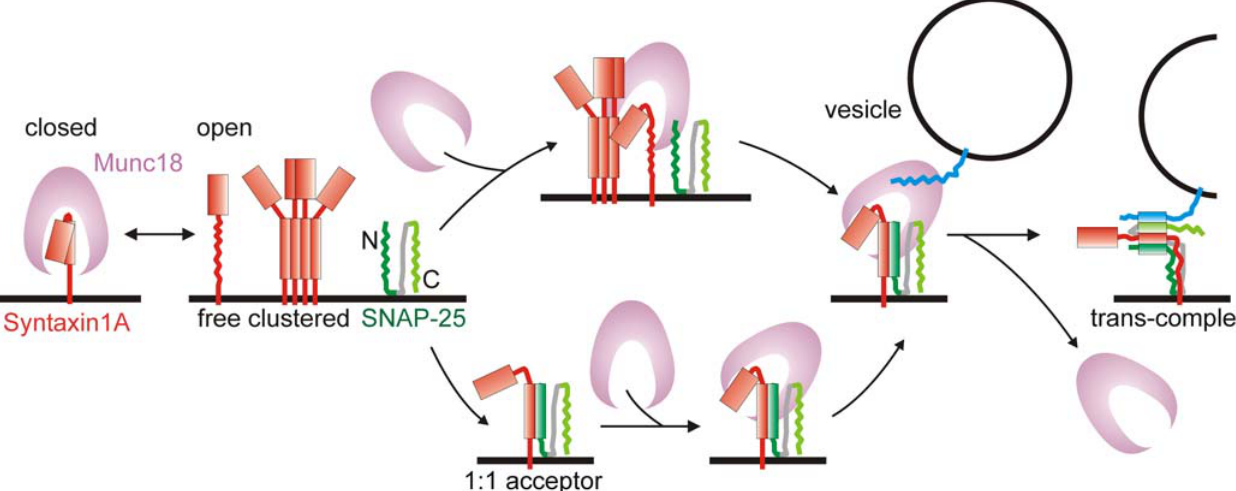
Figure 6. Model of Munc18–1 Function in the SNARE Assembly Pathway Munc18–1 binds to a partially closed conformation of syntaxin that is organized in clusters and that may (bottom branch) or may not (top branch) be associated with SNAP-25 at a 1:1 stoichiometry. After vesicle docking, synaptobrevin interacts with this complex, thereby displacing Munc18–1. Alternatively, SNAP-25 is not yet associated with the complex, and synaptobrevin binding is associated with the simultaneous recruitment of SNAP-25. As result, SNARE trans -complexes form, leading to exocytosis. It is possible that some syntaxin molecules that are freely diffusing in the membrane are capable of binding Munc18–1 with high affinity in a closed conformation (left) similar to that observed in solution, thereby preventing it from entering SNARE complexes. Such a pool could be reflected by Munc18–1 remaining membrane associated even after extensive washing periods. DOI: